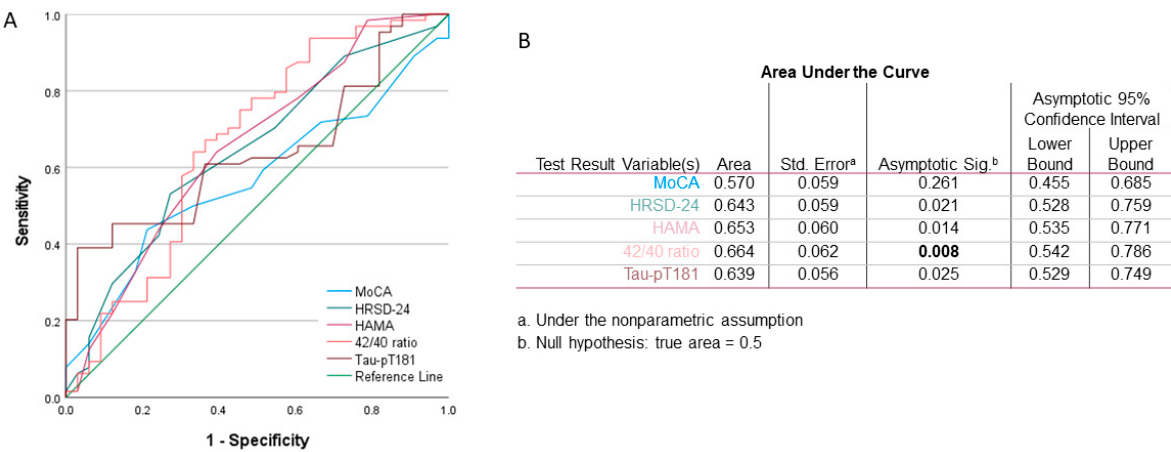
Figure 6. Receiver Operator Characteristic (ROC) analysis indicates that the A β 42/40 ratio has the highest potential for predicting sleep quality. ( A ) The ROC curves for the variables of A β 42/40 ratio, Tau-pT181, MoCA, HRSD-24, and HAMA scores. ( B ) Summary of the statistical values derived from the ROC curve analysis.